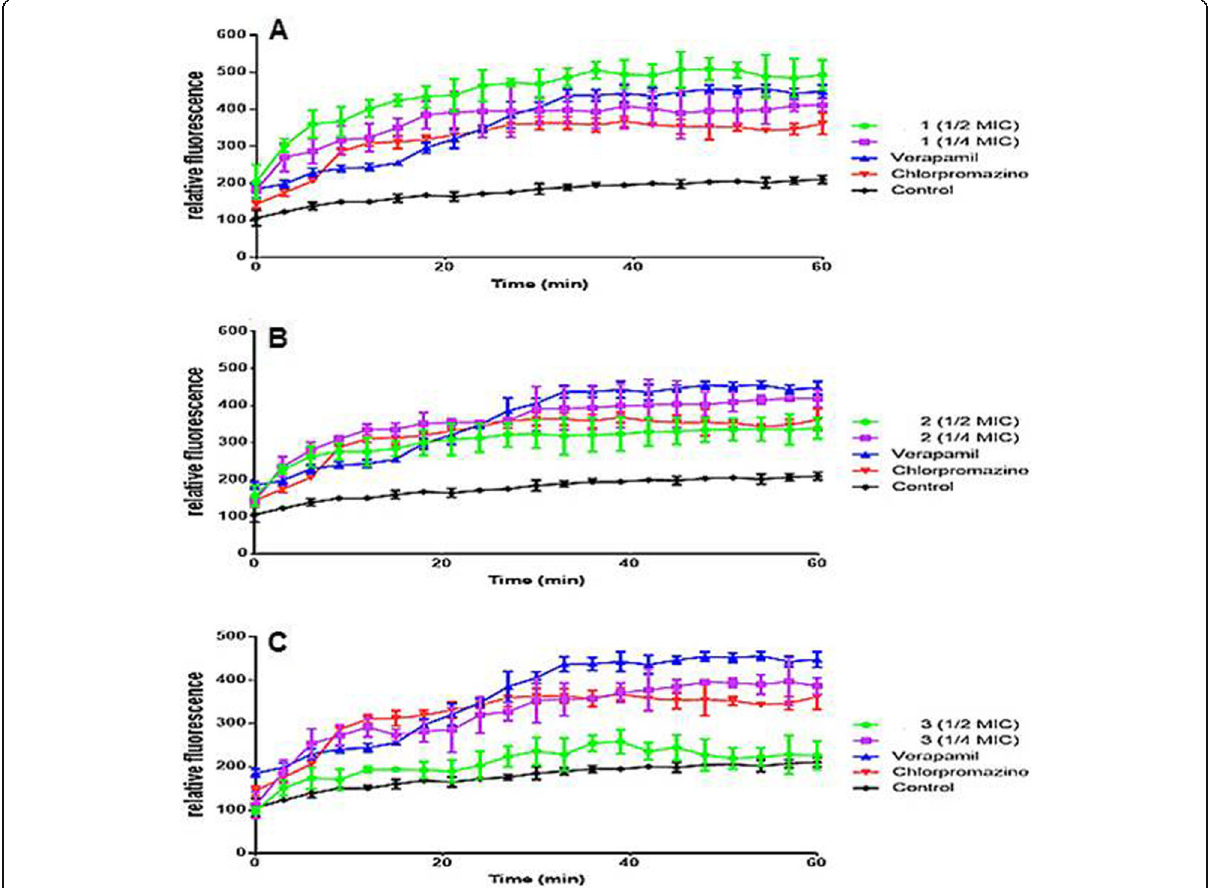
Fig. 5 Efflux pump inhibition effect of compounds 1 – 3 (A-C) in E.